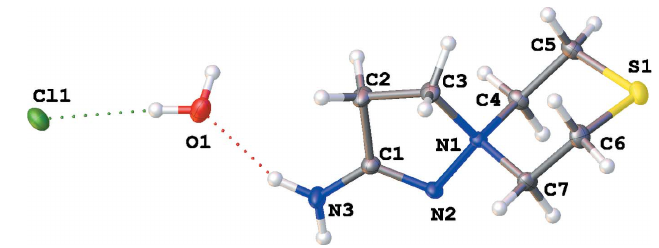
Figure 2 Asymmetric unit of 3 at low temperature with displacement ellipsoids at the 50% probability level.